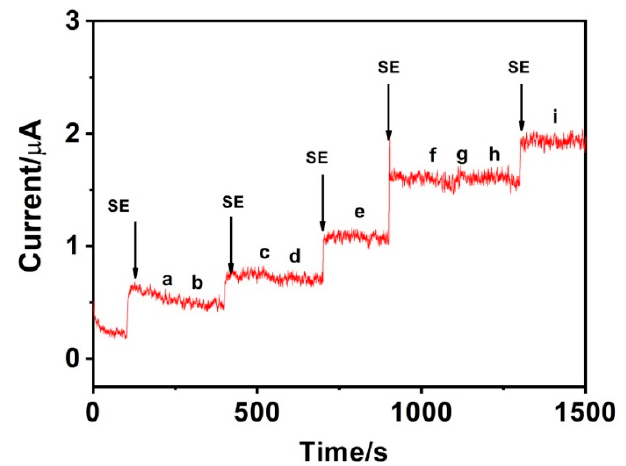
Figure 7. Amperometric response of the MnO 2 -GR modified GCE for the addition of 50 µ M SE and successive addition of interferents 500 µ M each in the sequence of (a) dopamine, (b) epinephrine, (c) folic acid, (d) uric acid, (e) ascorbic acid, (f) glucose (g) Na 2 + , (h) K + , and (i) Mg 2 + in 0.1 M PBS.